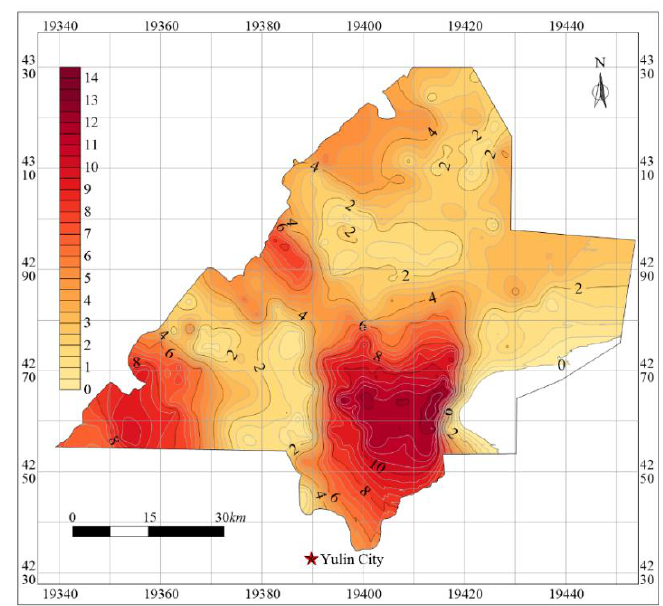
Figure 8. Coal thickness contour (Xi'an geodetic coordinate system 1980; in km).